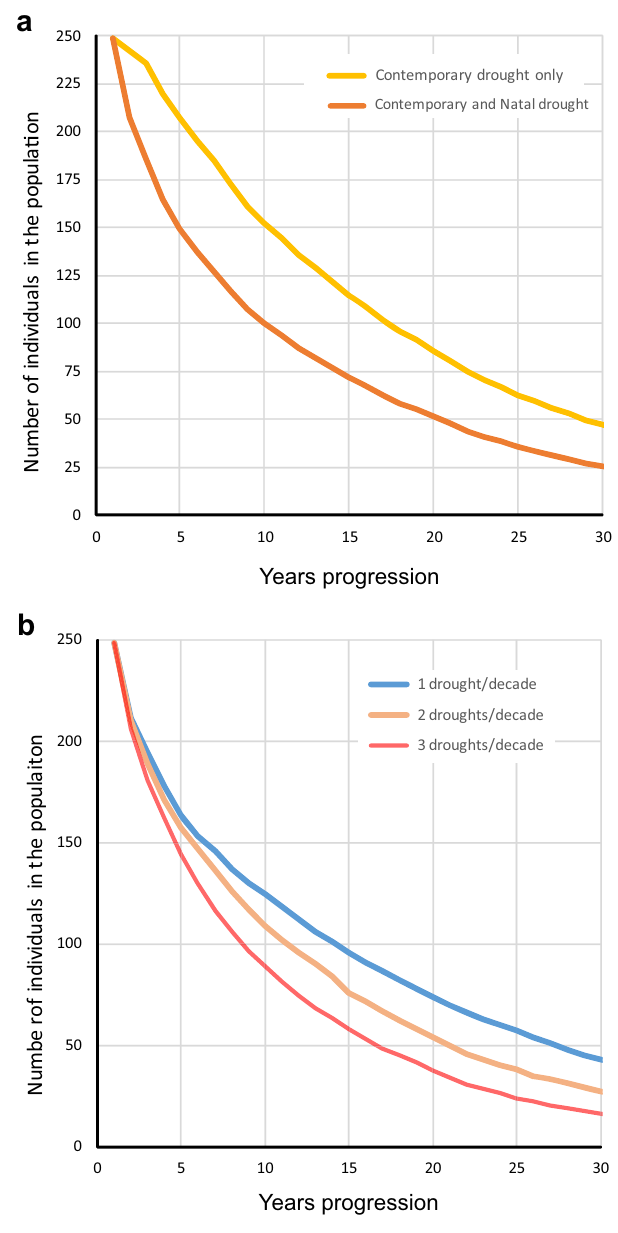
Fig. 5 | Impact of drought on the population dynamics of red kites in Doñana National Park (southwest Spain). Projected trajectory of the red kite population of Doñana, as estimated by matrix modelling (see Methods), when incorporating (brown line) or discounting (yellow line) the effect of natal drought ( a ). The fre- quency of drought was set to two per decade. Natal drought, which is usually ignoredinassessmentsofclimateimpacts,producedasteeperpopulationdecline ( a ). An increase in the decadal frequency of drought steepened the projected declineofthe population ( b ).Each line isthe populationtrajectory averagedover 100 time-series of randomly occurring droughts (see